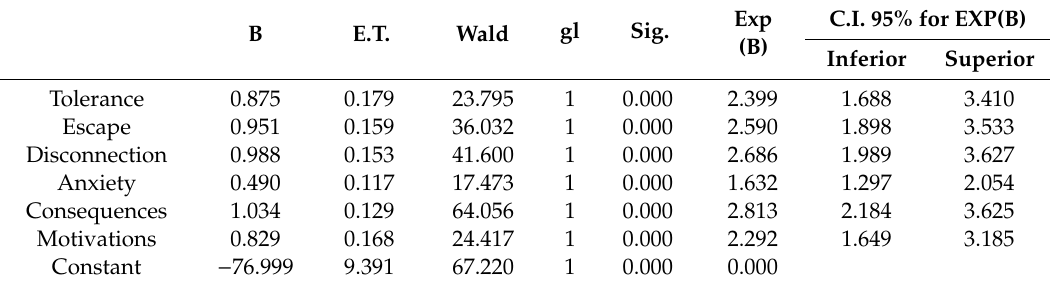
Table 9. Binary logistic regression of the self-perception of the problematic smartphones use a of university students aged between 18 and 20 years old with respect to the MPPUSA. C.I. 95% for EXP(B) Exp B E.T. Wald gl Sig. (B) Inferior Superior Tolerance 0.875 0.179 23.795 1 0.000 2.399 1.688 3.410 Escape 0.951 0.159 36.032 1 0.000 2.590 1.898 3.533 Disconnection 0.988 0.153 41.600 1 0.000 2.686 1.989 3.627 Anxiety 0.490 0.117 17.473 1 0.000 1.632 1.297 2.054 Consequences 1.034 0.129 64.056 1 0.000 2.813 2.184 3.625 Motivations 0.829 0.168 24.417 1 0.000 2.292 1.649 3.185 Constant − 76.999 9.391 67.220 1 0.000